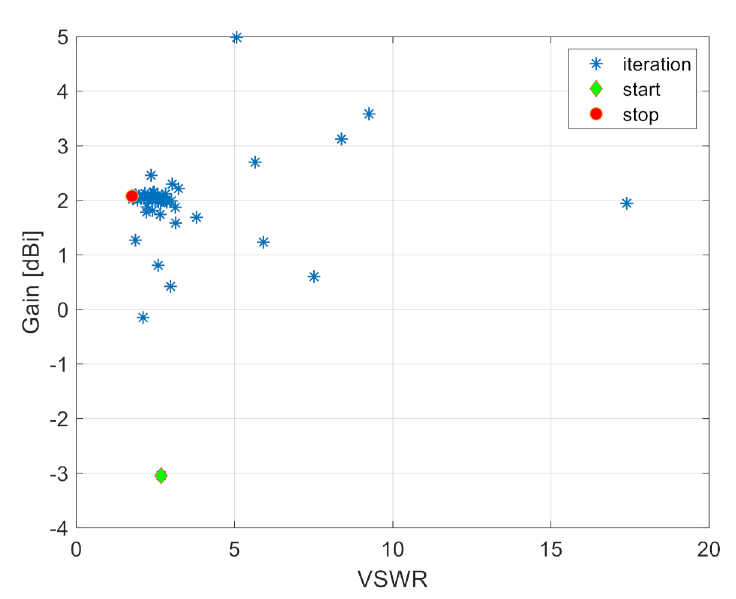
Figure 12. Objective space: history of optimization process of antenna with 3